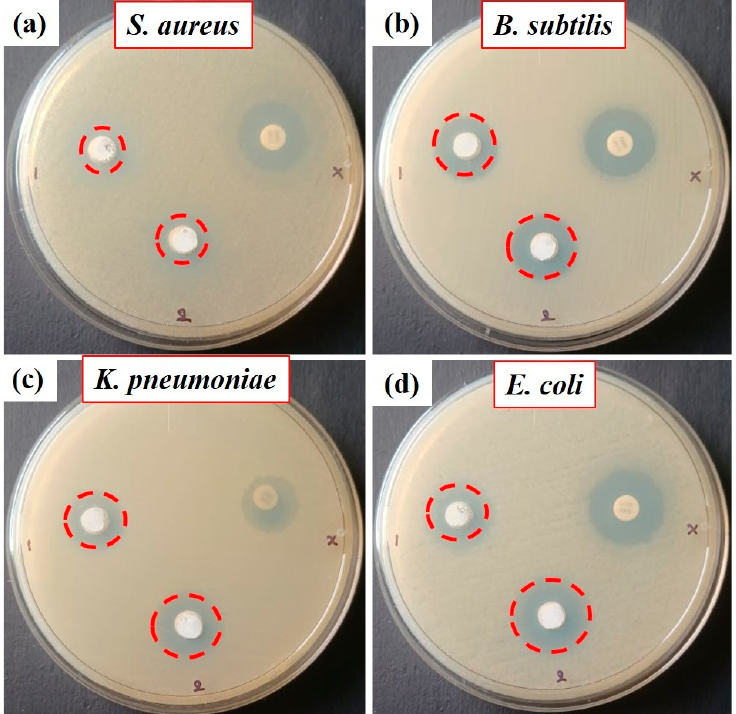
Figure 10. Antimicrobial properties of the ZnO NPs and 4DB:ZnO NPs against pathogenic bacteria.